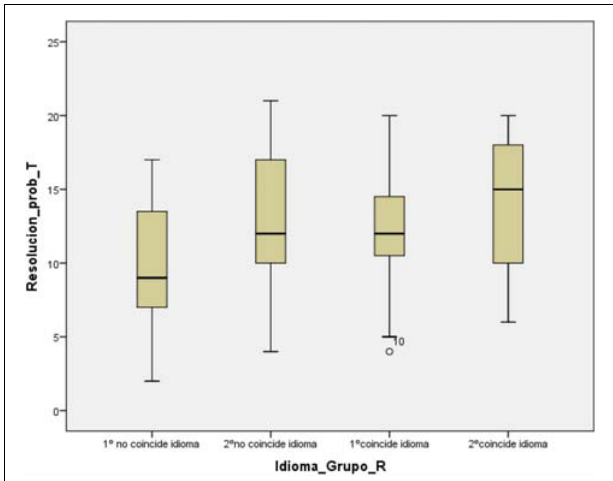
FIGURE 3 | Problem solving × language of instruction × grade. Source: Prepared by the authors on the basis of data.